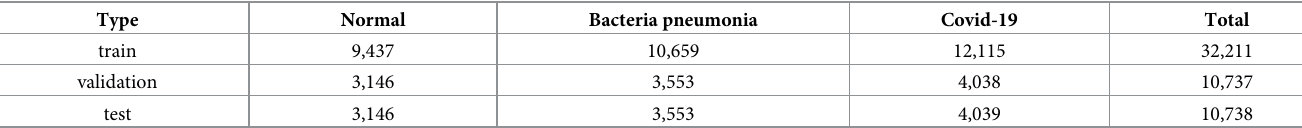
Table 1. The detailed description of the datasets used in this work.